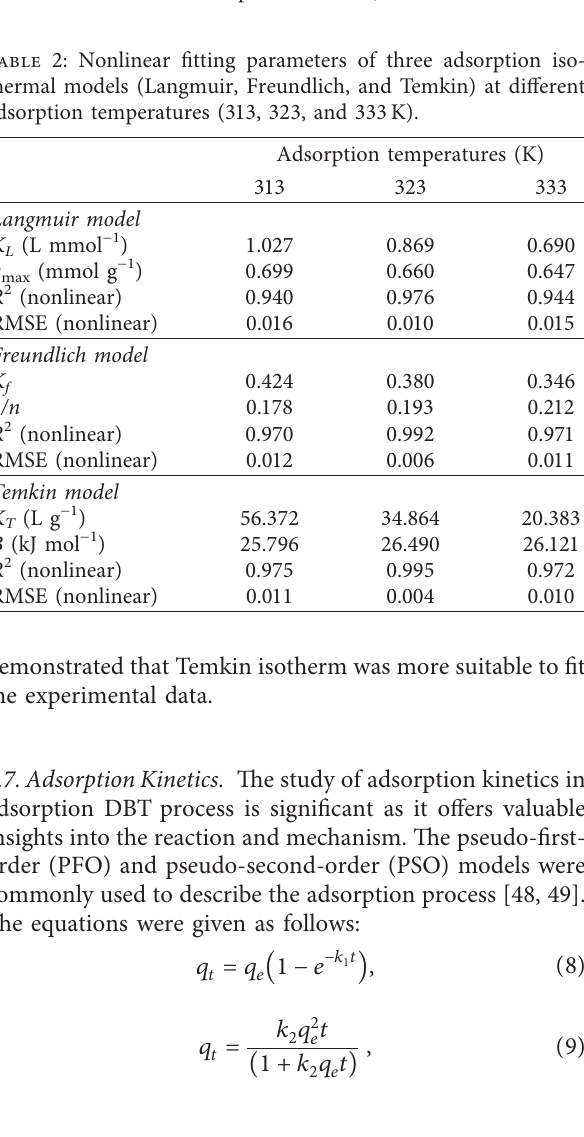
Figure 12: Nonlinear fitting of Freundlich model (adsorbent: 0.2g 2 wt. %; v : 20 mL; c 0 : 6.25, 7.81, 9.38, 12.50, 15.63, 18.75, and oil 21.88mmol · L − 1 DBT; adsorption time: 4h).